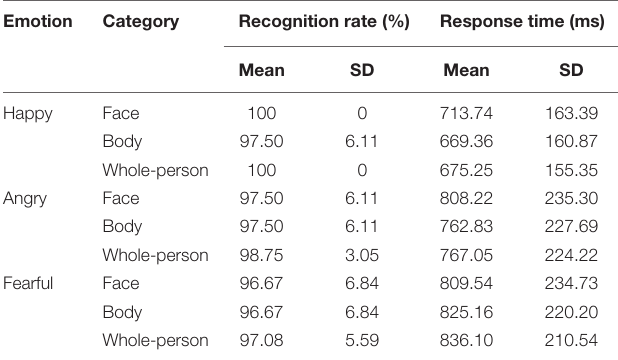
TABLE 1 | Mean emotion identification accuracies and corresponding response